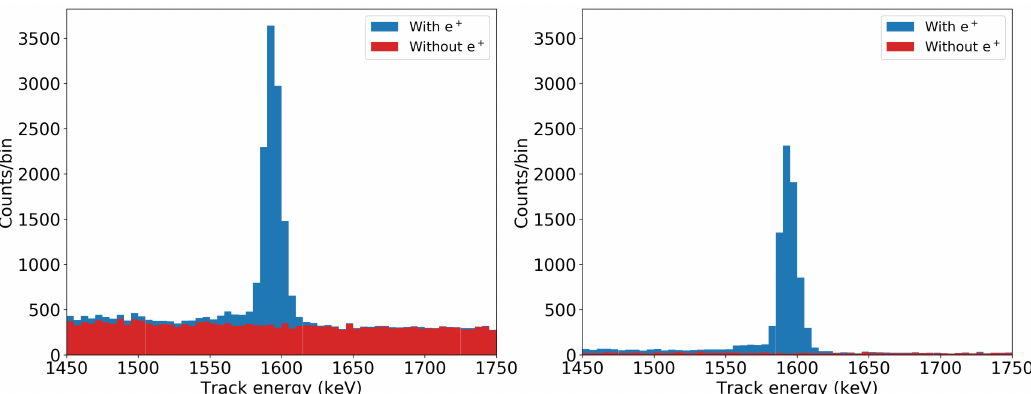
Figure 9 . Energy spectrum and event population in the double escape peak region for MC events. In blue, events with a positron, in red — the rest of the interactions (predominantly Compton electrons). Left: the spectrum before applying any topological cut. Right: after a blob2 energy cut of 340